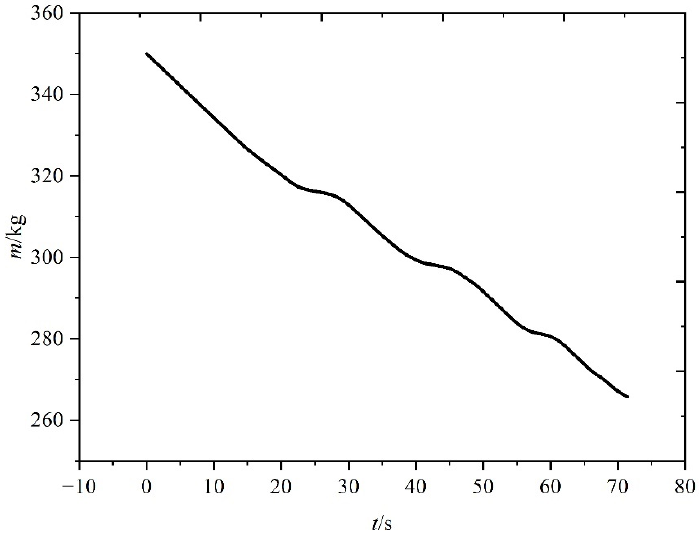
Figure 14. Vehicle mass under case 1 in the third scenario vs. time.